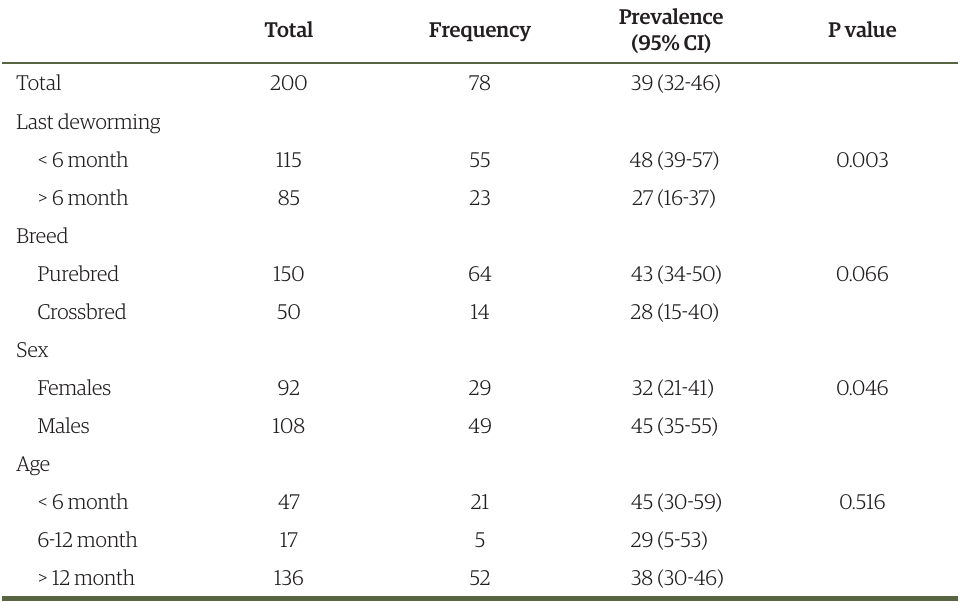
Table 1. Prevalence of gastrointestinal parasites according to deworming time, breed, sex and age in dogs.